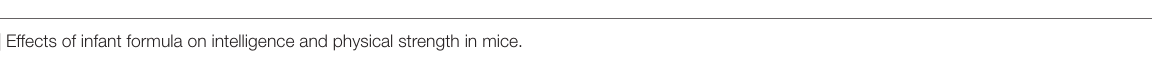
FIGURE 5 | Effects of infant formula on the growth of mice, n = 10 independent experiments. Changes in (A) body weight, (B) body length and (C) tail length of mice during the 30-day feeding period. (D) Morphology of the small intestines of mice. (E) Villus height and (F) crypt depth in the small intestines of mice.